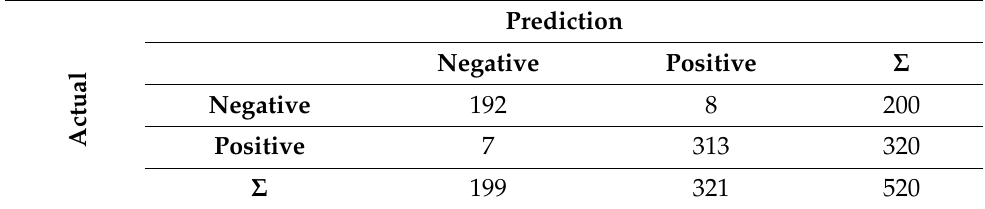
Table 8. Confusion Matrix of Support Vector Machine (SVM) Classification.